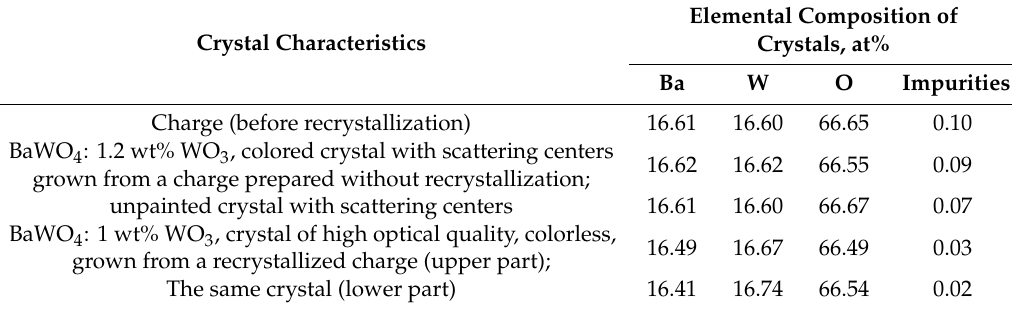
Table 1. Content of main components and impurities in grown crystals of nominally pure barium tungstate.